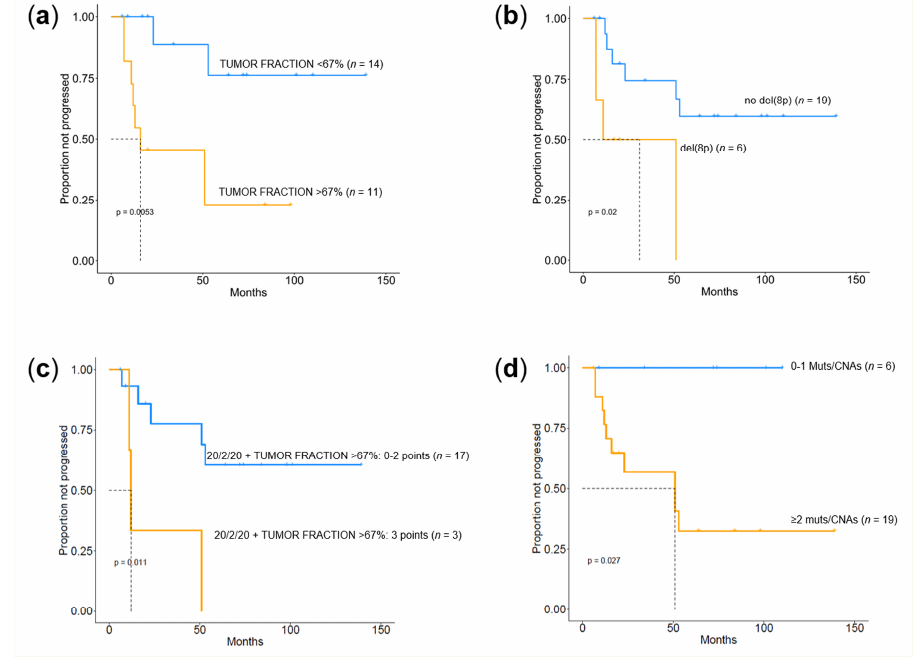
Figure 4. Kaplan–Meier curves of time to progression (TTP) by next-generation sequencing (NGS)-derived molecular information in SMM. Kaplan–Meier curves of TTP according to the ichorCNA-estimated tumor fraction of bone marrow (BM) plasma cell (PC) genomic DNA ( a ), the occurrence of deletions in chromosome arm 8p ( b ), the 20 / 2 / 20 model integrated with the tumor fraction of BM PC genomic DNA ( c ), and the number of mutational and CNA events carried by each patient ( d